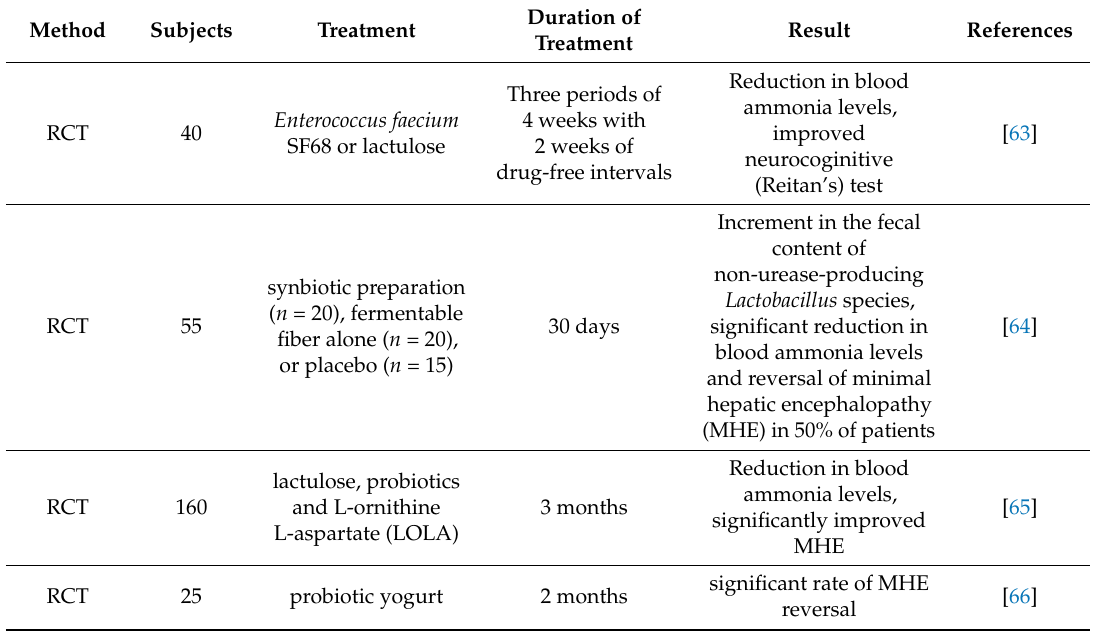
Table 1. Limited clinical trials in patient with Liver